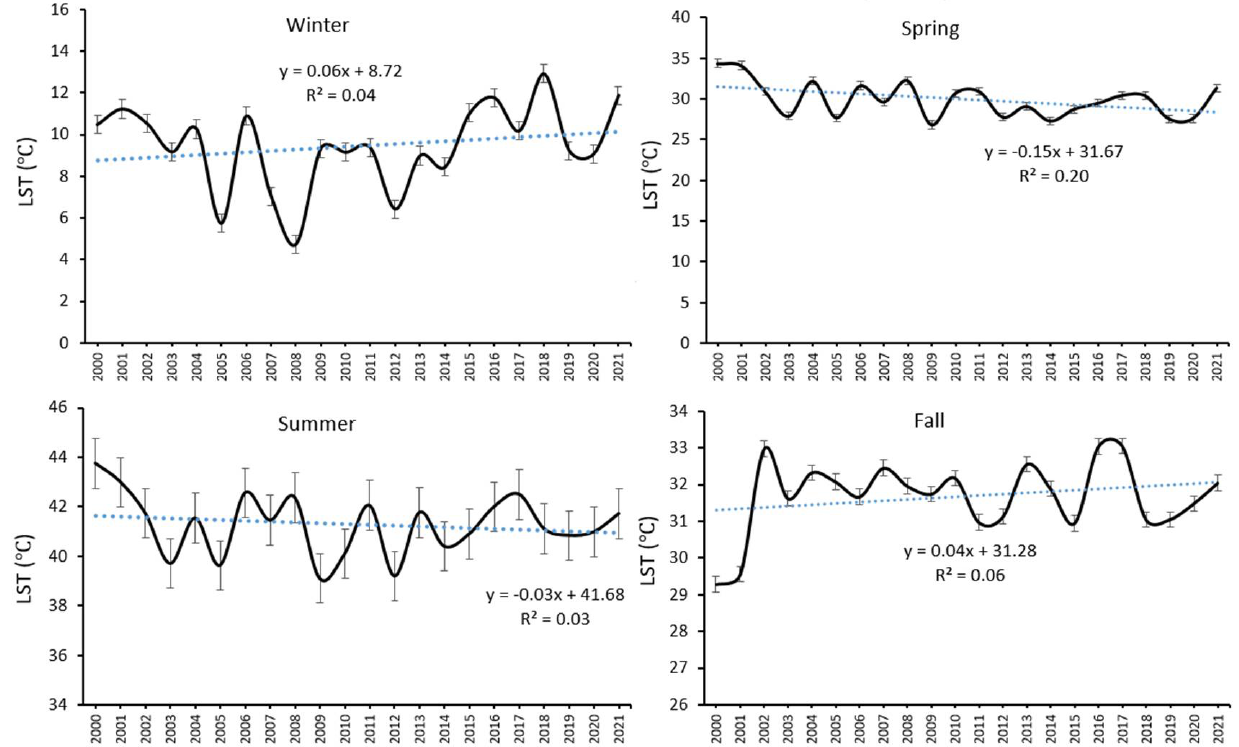
Figure 5. Time series of seasonal LST in Afghanistan in the period 2000–2021.